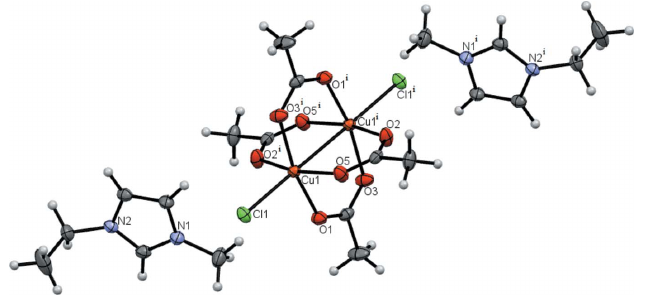
Figure 1 Compound 1 with displacement ellipsoids drawn at the 50% probability level. [Symmetry code: (i) (cid:2) x , 1 (cid:2) y , 2 (cid:2) z .]